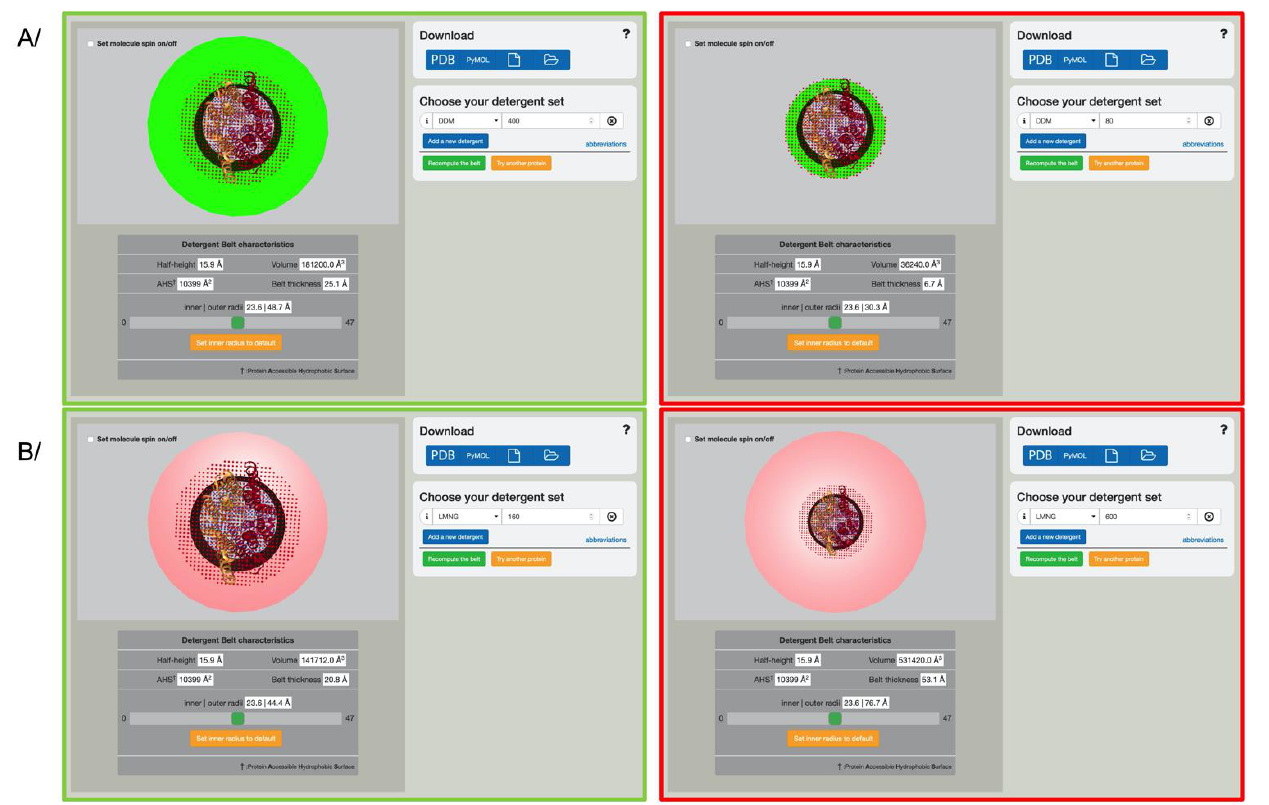
Figure 2. Interactive detergent belt visualization. ( A ) ABC transporter with a DDM belt modeled (green belt). The left panel shows the measured amount of DDM (400 monomers), while the right panel shows the same protein embedded in a DDM micelle (80 monomers). ( B ) same as ( A ) in the detergent LMNG (pink belt). The left panel displays the 160 monomers measured, while the right panel shows an arbitrary micelle number of 600. PDB code used in this figure: 2hyd.